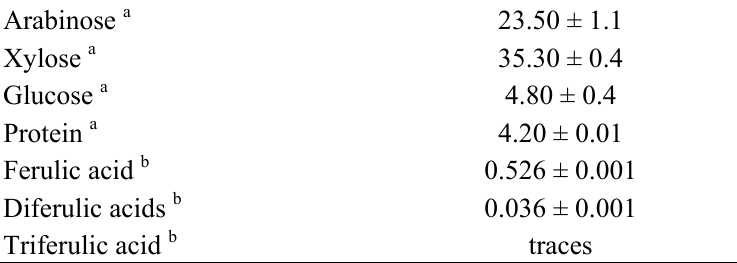
Table 1. Composition of water extractable